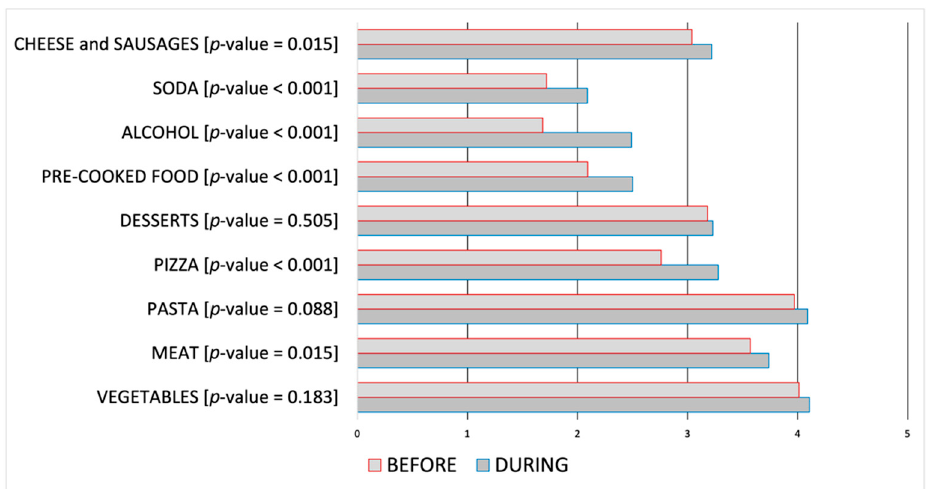
Figure 3. Dietary habits before and during the SARS-CoV-2 lockdown period, within the range 0 (never) to 5 (always).